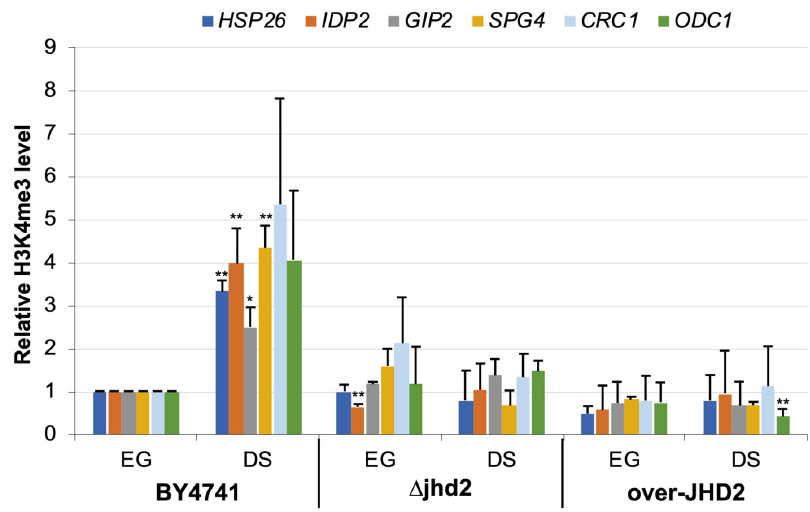
Figure 2. H3K4 trimethylation in the proximal ORF portion of HSP26, IDP2, GIP2, SPG4, CRC1 and ODC1 at EG and DS in the wild type strain BY4741; in the isogenic ∆ JHD2 strain and in a strain overproducing Jhd2 (over-JHD2, see Table 1). * = p < 0.05; ** = p < 0.01 according to Student’s t-test